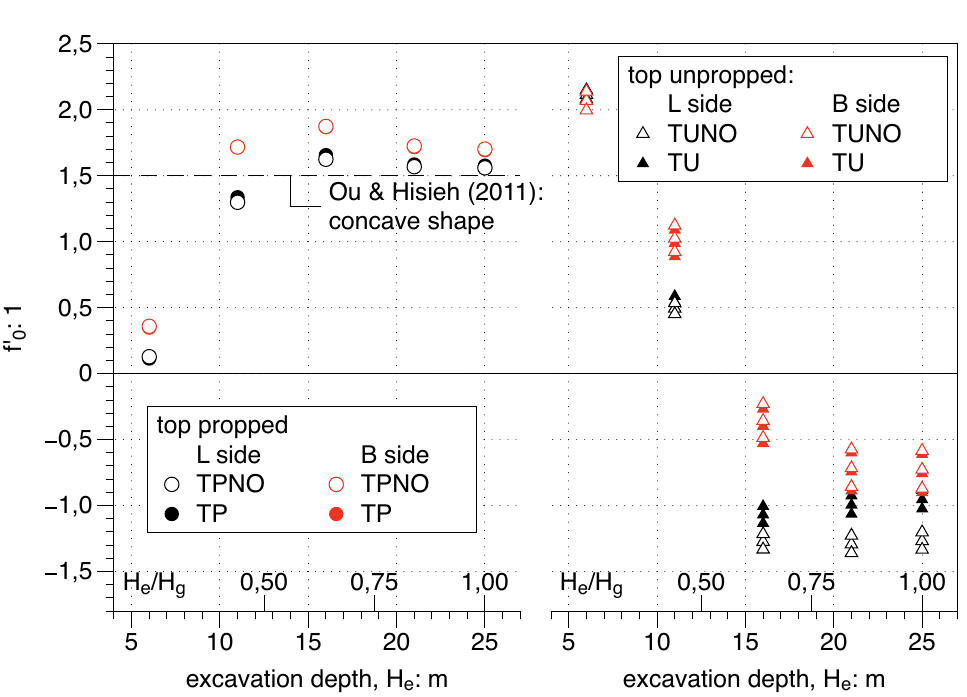
Figure 14. Dependency on the excavation depth H e of the slope f ′ 0 of the transversal settlement profile path at the edge of the